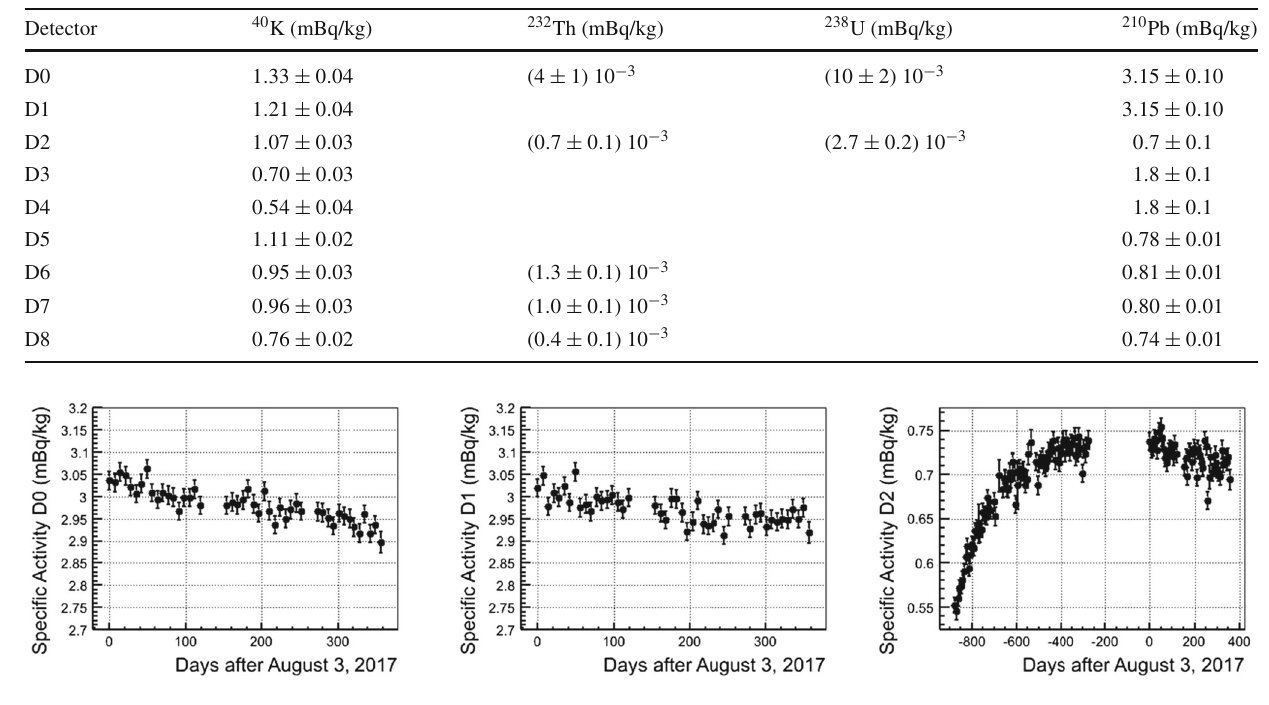
Table 3 Measured activity in NaI(Tl) crystals determined indepen- dently for each one of the nine ANAIS-112 detectors combining differ- ent analysis techniques. Quantification of 232 Th and 238 U activity by analyzing the alpha events has only been possible for some detectors as